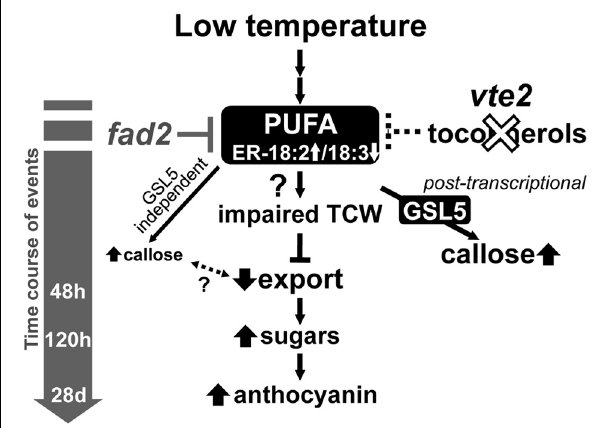
FIGURE 7 | A proposed model of the timing of biochemical changes in LT-induced phenotypes of tocopherol-deficient mutants. Tocopherol deficiency, e.g., by the vte2 mutation, leads to constitutive alterations in the fatty acid composition of endoplasmic reticulum (ER) membrane lipids [i.e., reduced linolenic acid (18:3) and increased linoleic acid (18:2)]. These alterations are suppressed by the mutation of the ER FATTY ACID DESATURASE 2 gene ( fad2 ), which also suppresses all of the LT-induced vte2 phenotypes (Maeda et al., 2008; Song et al., 2010). Subsequent vasculature-specific callose deposition is primarily mediated by the GSL5 enzyme and tocopherol-deficiency affects its activity post-transcriptionally. Although low levels of GSL5-independent callose deposition still occurs, loss of the massive GSL5-dependent callose deposition in transfer cells does not affected the subsequent defect in photoassimilate export in LT-treated vte2